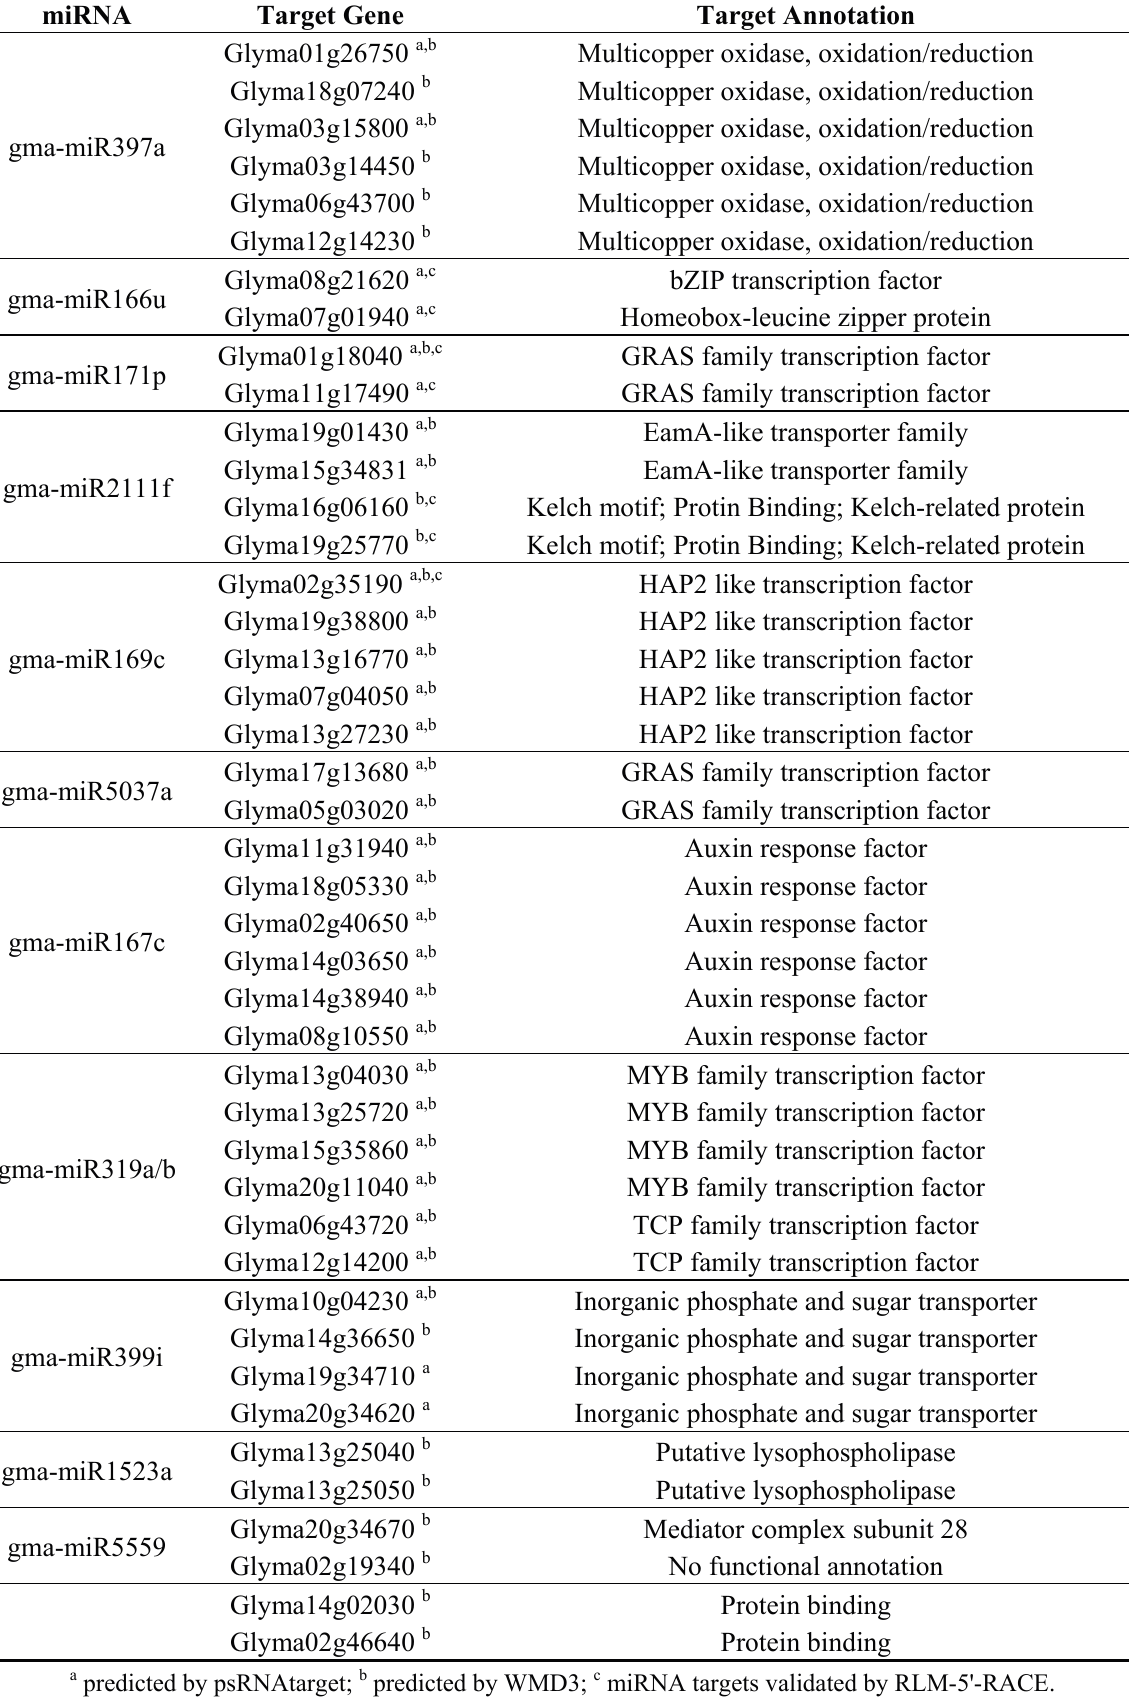
Table 1. Putative target genes of known cold-responsive miRNAs and their function annotations.